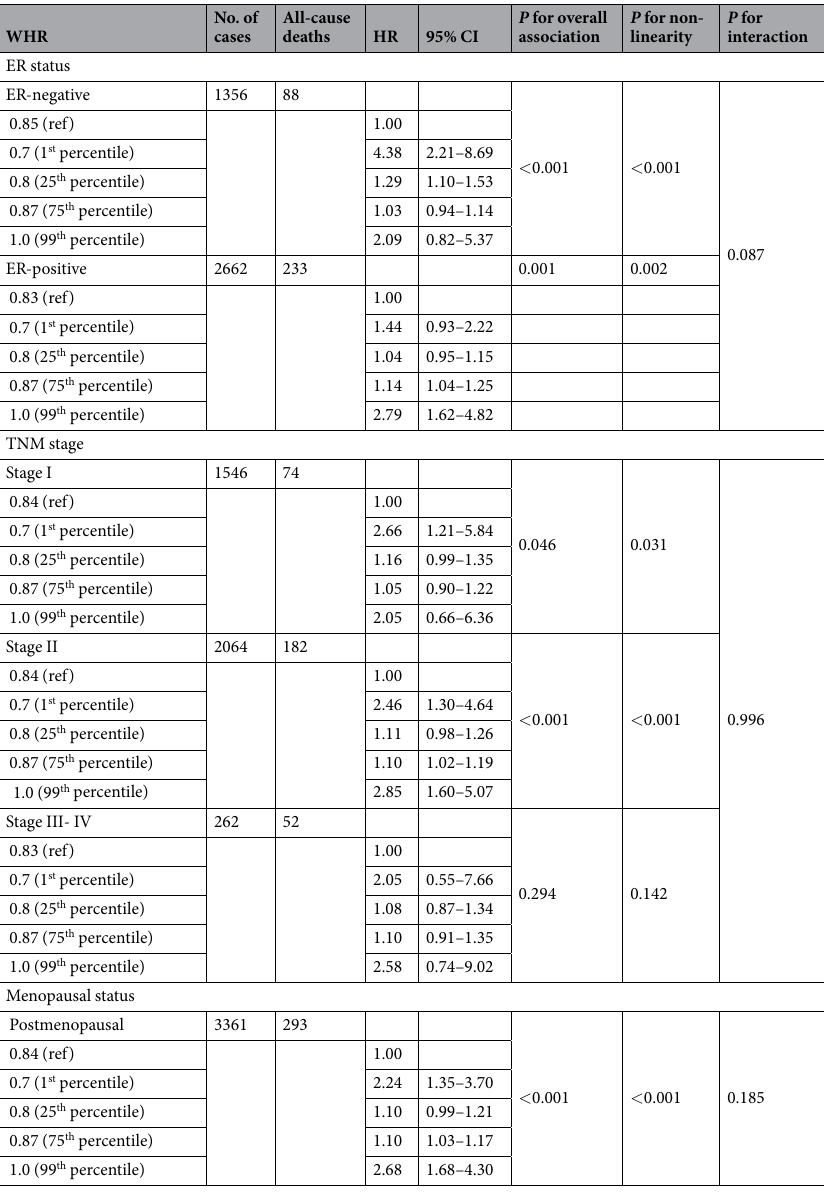
Table 5. Hazard ratios and 95% confidence intervals for post-diagnosis WHR in association with late all-cause mortality by ER status and menopausal status, the Shanghai Breast Cancer Survival